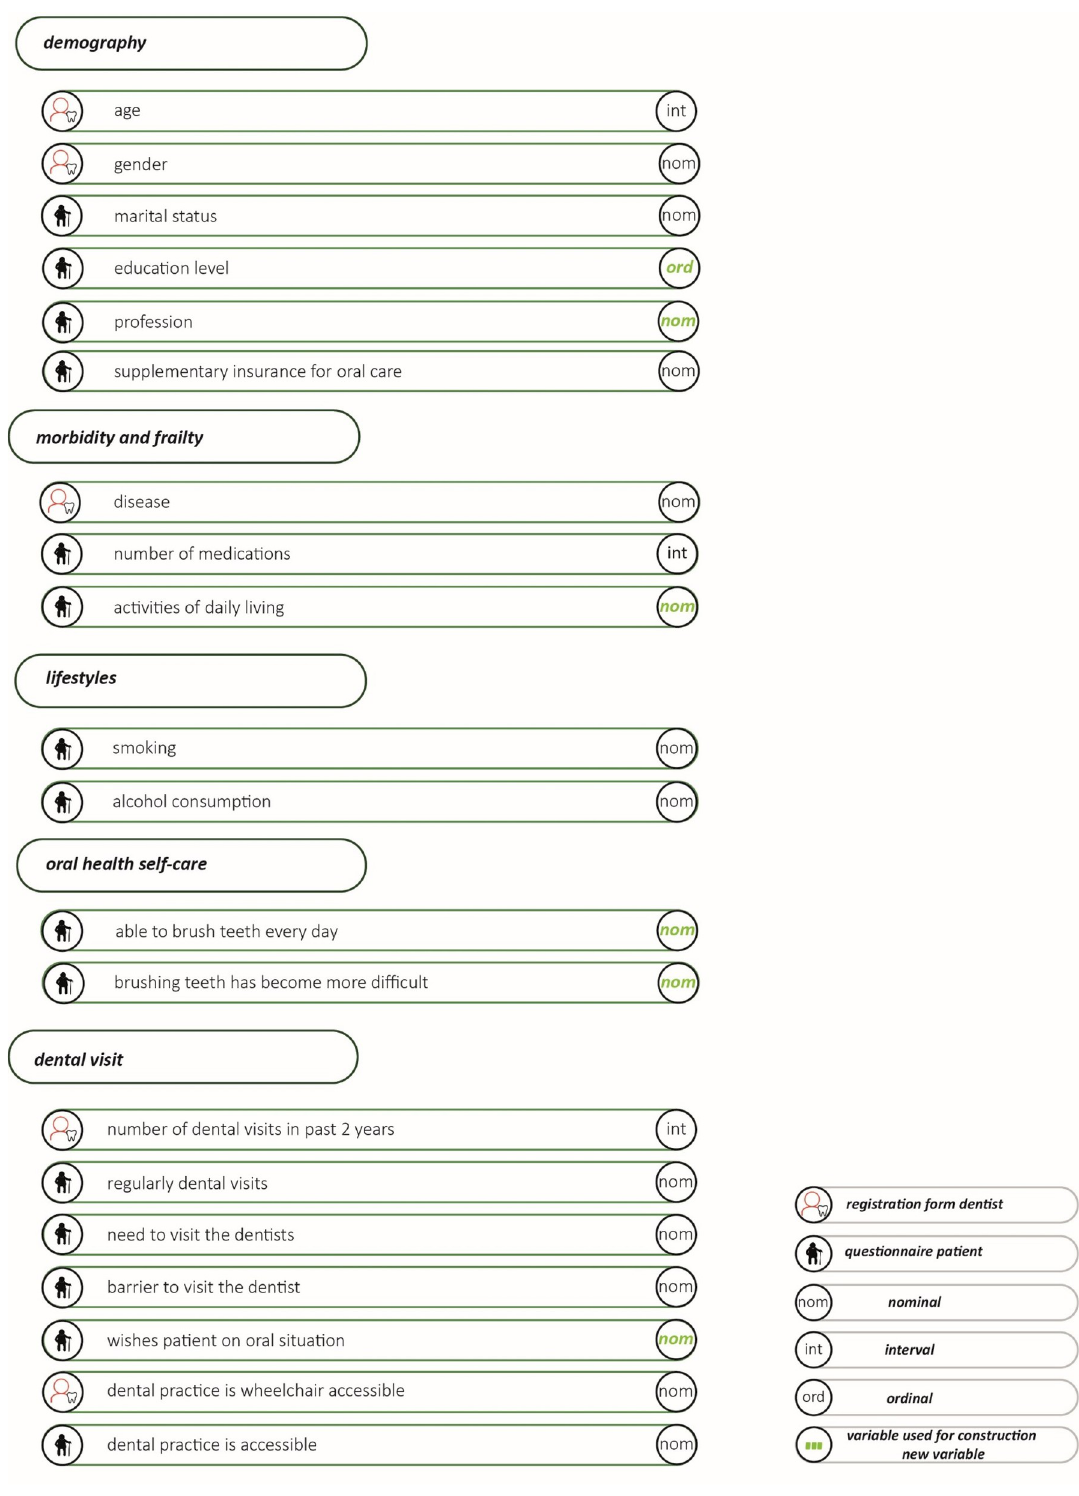
Fig 3. Overview of variables used in